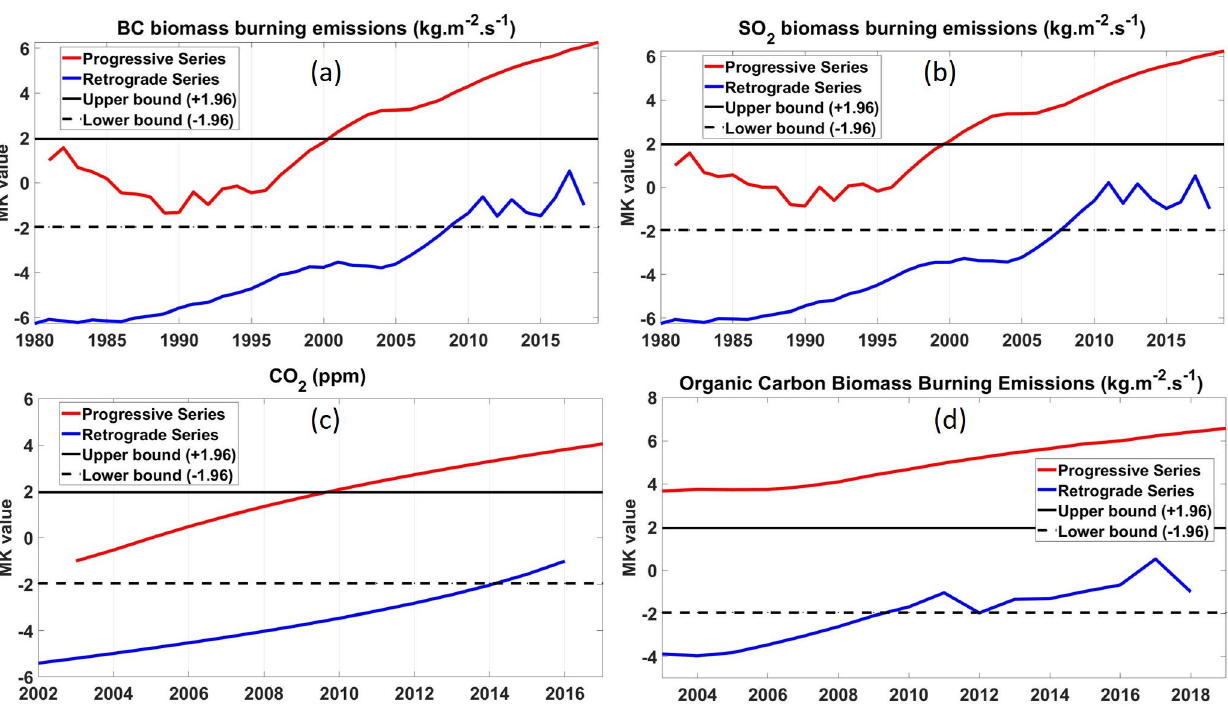
Figure 9. SQ–MK trends in ( a ) BC, ( b ) SO 2 , ( c ) CO 2 and ( d ) OC over the MP and KZN